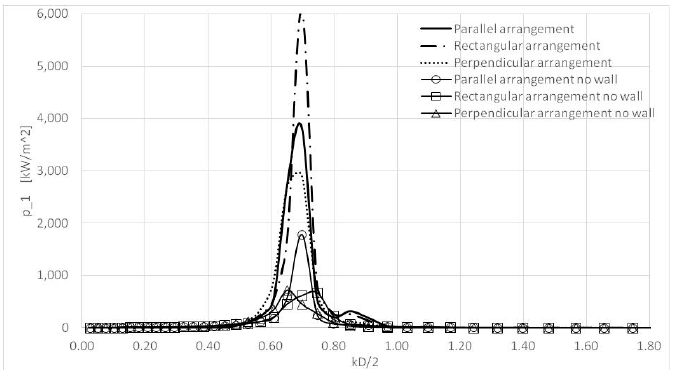
Figure 24. Absorbed wave power by the 1st cylindrical floater against kD / 2, for the parallel, C 1, rectangular, C 2 ; and perpendicular, C 3 arrangement. The results are also compared with the absorbed power of the same floater of the arrangements without the presence of the wall.